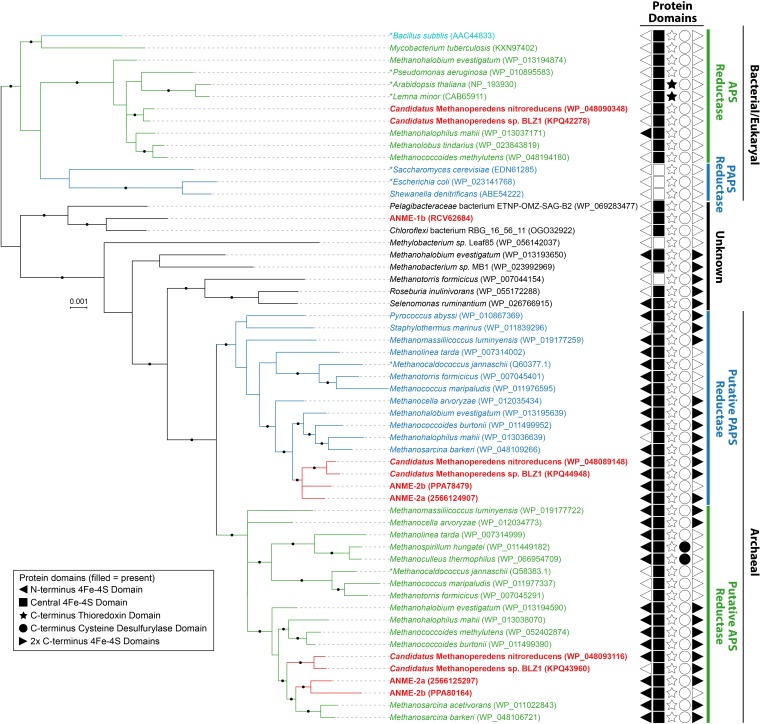
Bayesian phylogeny of assimilatory adenyl-sulfate (APS) reductases and phosphoadenylyl-sulfate (PAPS) reductases. APS reductases and putative APS reductases are in green, PAPS reductases and putative PAPS reductases are in blue, bifunctional APS and PAPS reductase of Bacillus subtilis is in teal, and ANME proteins are bolded and in red. Archaeal and Bacterial/Eukaryal sequences formed separate clusters. Asterisks (∗) indicate proteins that have been studied biochemically from Archaea (Lee et al., 2011; Cho, 2013), or Bacteria/Eukaryotes (Gutierrez-Marcos et al., 1996; Savage et al., 1997; Suter et al., 2000; Berndt et al., 2004; Kim et al., 2004; Yu et al., 2008). Length of the proteins ranged from 239 to 896 amino acids with the addition of protein domains. The protein domains, if found, are shown with filled symbols. Only 172 amino acid residues of the central shared region were used for phylogenetics. Given that two copies of APS/PAPS reductases were found in each ANME-2 lineage and clustered separately, it is likely one is for APS and the other is for PAPS reduction similar to M. jannaschii (Lee et al., 2011; Cho, 2013). Ca. Methanoperedens and four other methanogens in Methanosarcinales also contained a second putative assimilatory APS reductase more closely related to the bacterial/eukaryotic homologs, while ANME-1b contained a gene that does not cluster with assimilatory APS or PAPS reductases of known substrate. Protein accession numbers from the NCBI database or gene IDs from the IMG database are shown in parentheses. Black dots on the branches represent Bayesian posterior probability values greater than 90%, and scale bar indicates the number of amino acid substitutions per site.